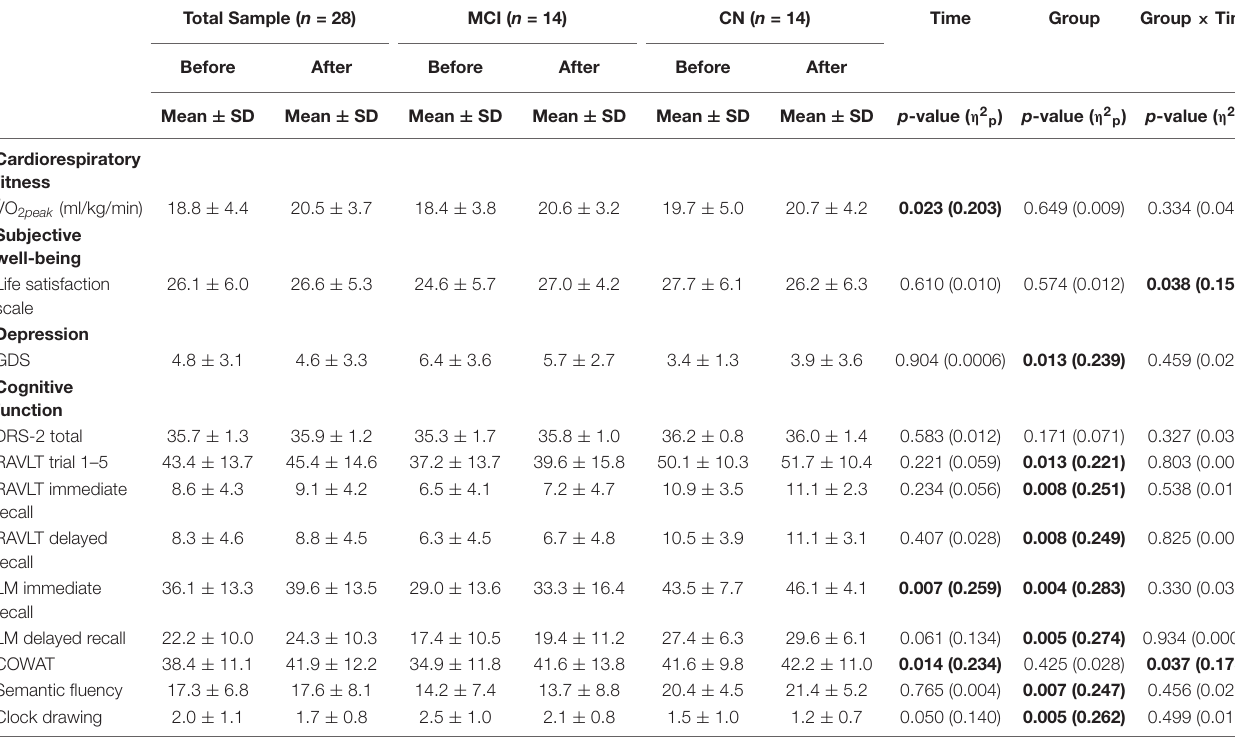
TABLE 2 | Cardiorespiratory fitness, life satisfaction, GDS, and cognitive function data for study participants. Total Sample ( n = 28) MCI ( n = 14) CN ( n = 14) Time Group Group × Time Before After Before After Before